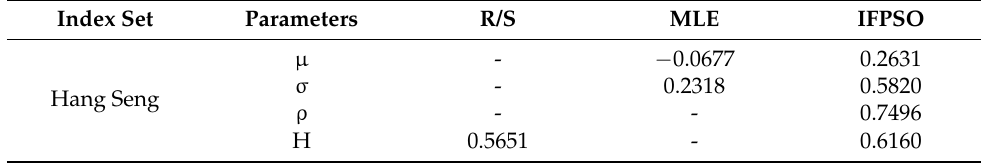
Table 6. MFBM model parameters and optimization results for the Hang Seng